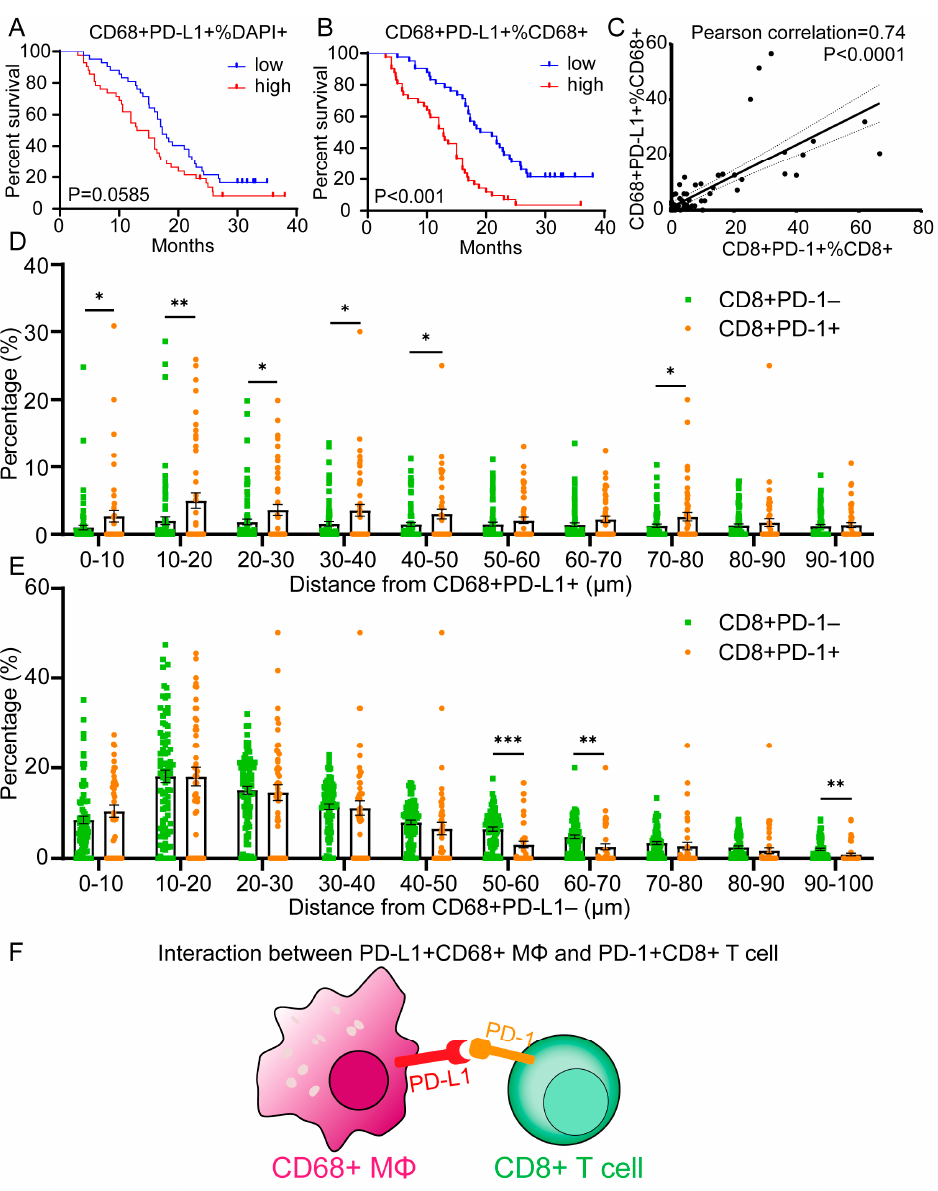
Figure 5. The spatial analysis revealed that the PD-1 + CD8 + cells were close to the PD-L1 + CD68 + cells within the TME. ( A ) A Kaplan–Meier curve showing that a low proportion of CD68 + PD-L1 + among all cells tended to predict longer overall survival (OS) times ( p = 0.0585). ( B ) A Kaplan–Meier curve illustrating the significant prognostic effect on OS based on the proportion of CD68 + PD-L1 + cells among the CD68 + cells ( p < 0.001). ( C ) A scatter plot showing the significant positive correlation between the proportion of PD-1 + CD8 + among the CD8 + TILs and PD-L1 + CD68 + among the CD68 + TAMs with the best-fit line shown. The Pearson’s correlation coefficient (r value) and the p value are provided at the top. ( D ) A spatial plot showing the distribution of PD-1 + CD8 + cells and PD-1 - CD8 + cells from the PD-L1 + CD68 + cells. ( E ) A spatial plot showing the distribution of PD-1 + CD8 + cells and PD-1 - CD8 + cells from the PD-L1 - CD68 + cells. ( F ) A diagram depicting the interaction between the PD-L1+CD68+ macrophage and the PD-1 + CD8 + T cell. The median was used as a cutoff value to classify patients into high- and low-expression groups. The error bars represent SEMs. A log-rank test was used to compare the survival significance. The statistical analyses between the two groups were conducted using Student’s t -tests. *: p < 0.05; **: p < 0.01; ***: p < 0.001.